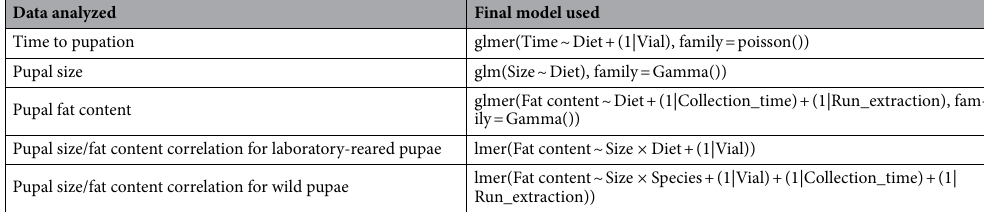
Table 1. Final models used (after model simplification) for statistical analysis in